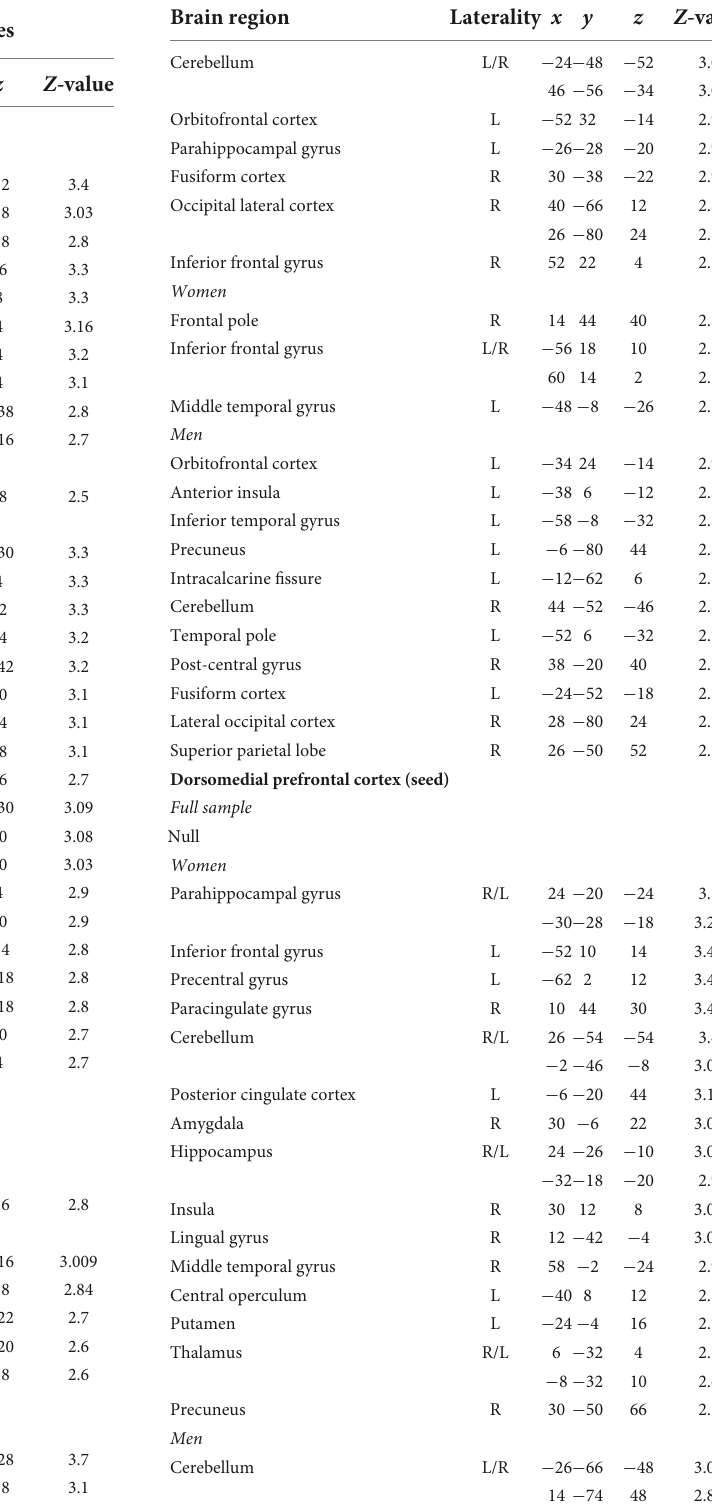
TABLE 1 Brain regions presenting significant functional connectivity with four different seed regions: anterior cingulate cortex